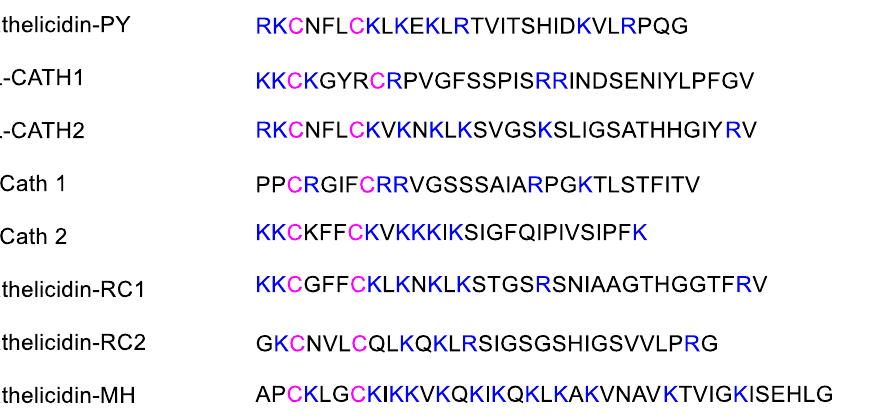
Figure 1. Sequence alignment of recently discovered amphibian cathelicidins, mature peptides shown. Blue denotes cationic residues and pink denotes the cysteine residues forming a disulfide bond.